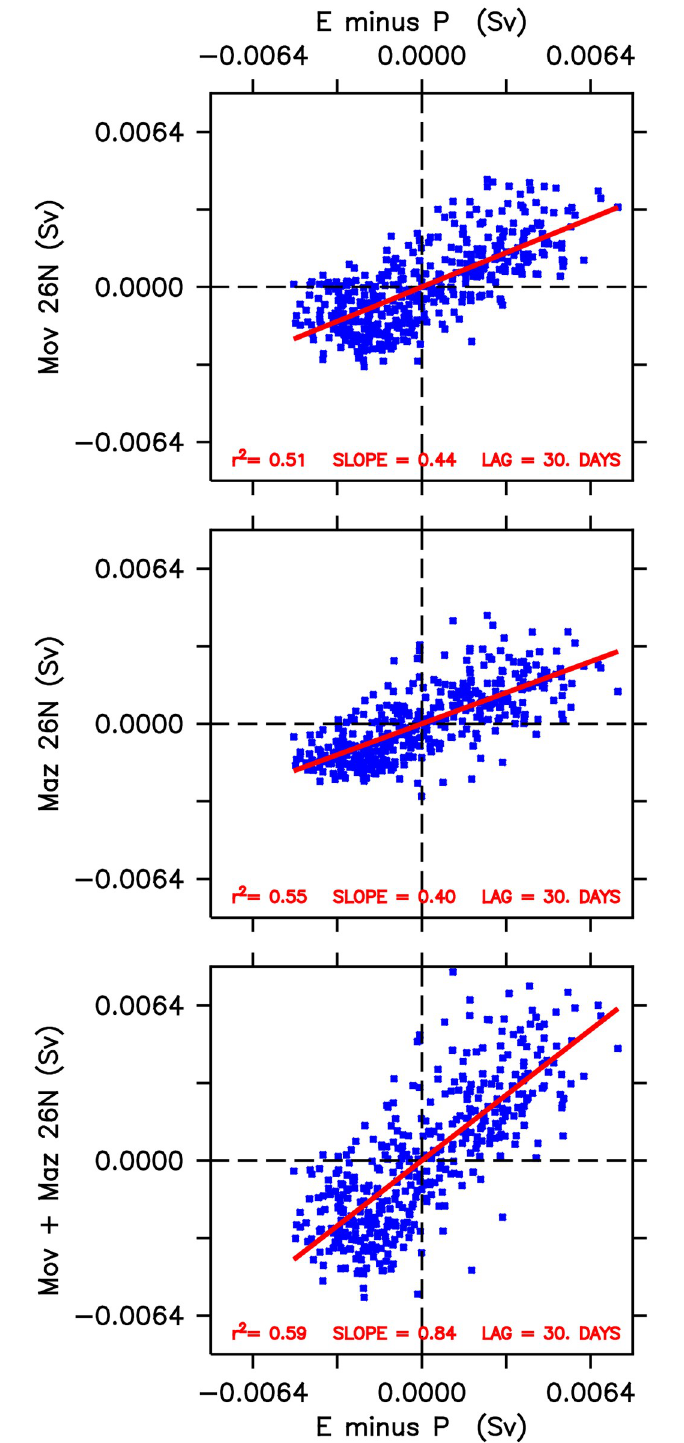
Fig 11. Scatterplots btween EMP and the horizontal and overturing components of the baroclinic transport across Hormuz, at a one-month time lag.